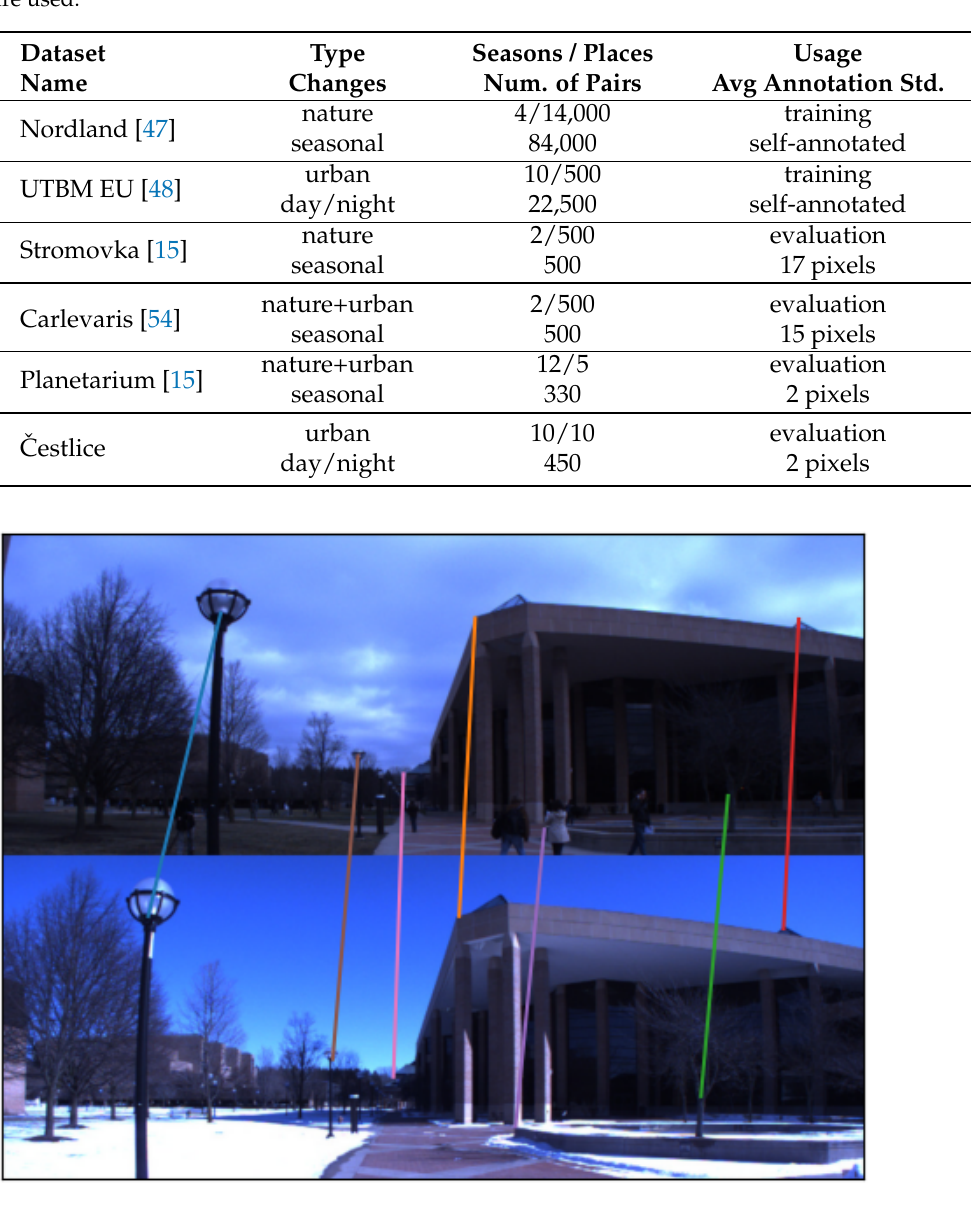
Figure 8. A sample of annotated image pair from Carlevaris dataset. The annotations are visualized as color lines that connect the two images’ correspondences. Both images are taken from a similar place, so the individual annotations have a slight variance in displacement correspondence in the x